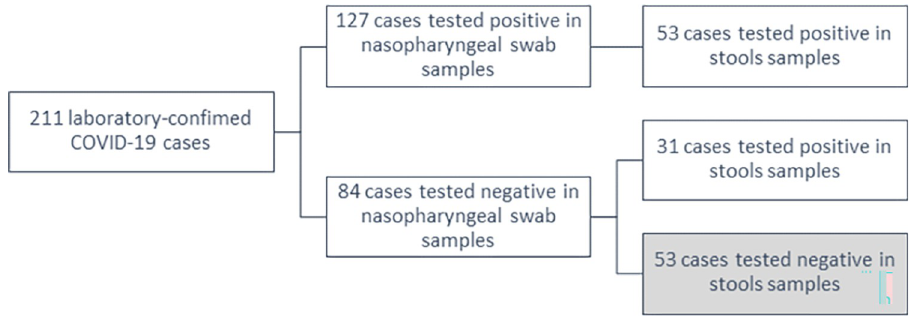
Fig 1. SARS-CoV-2 PCR test results among COVID-19